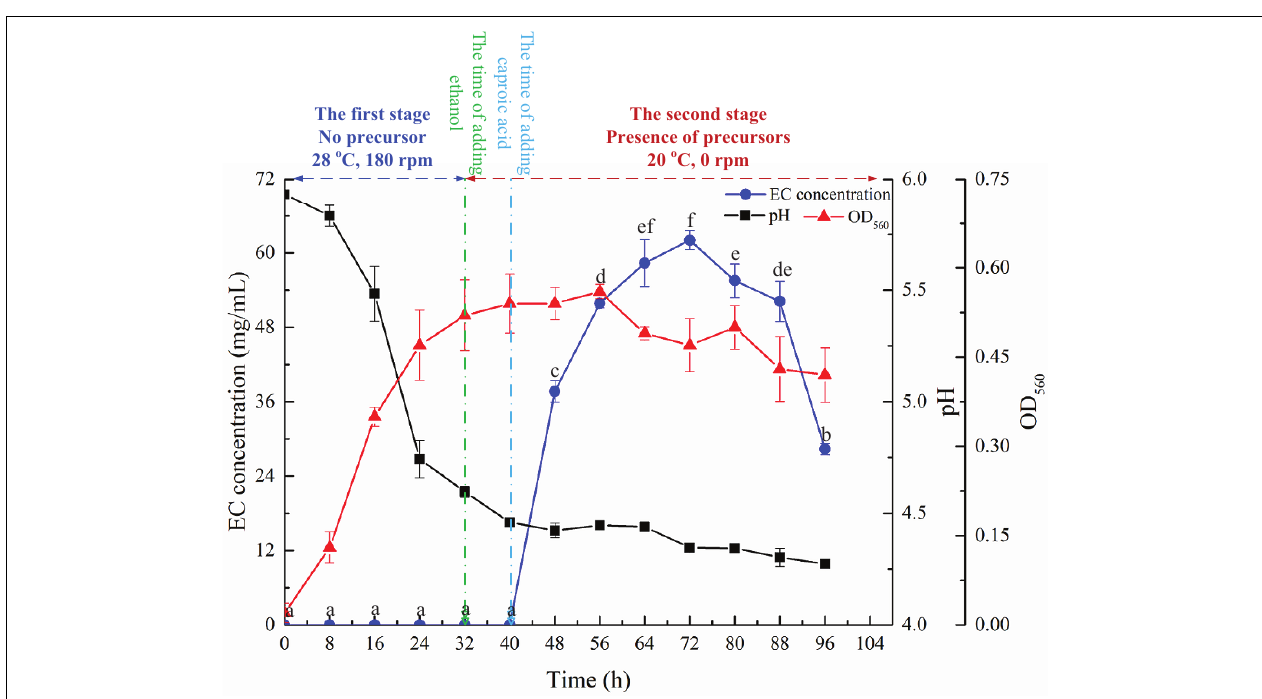
FIGURE 6 | Effect of culture time on EC production by YX3307. Same letters in the column indicates that the data do not differ significantly at 5% probability by the Tukey test.